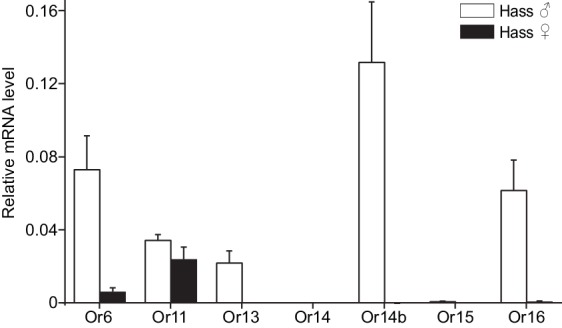
Relative mRNA expression levels of PRs by quantitative real-time PCR analysis in male and female antennae of H.assulta. Hass♂, male antennae; Hass♀, female antennae. n = 3 replicates of 40–60 antennae each. Data are presented as mean ± SEM.